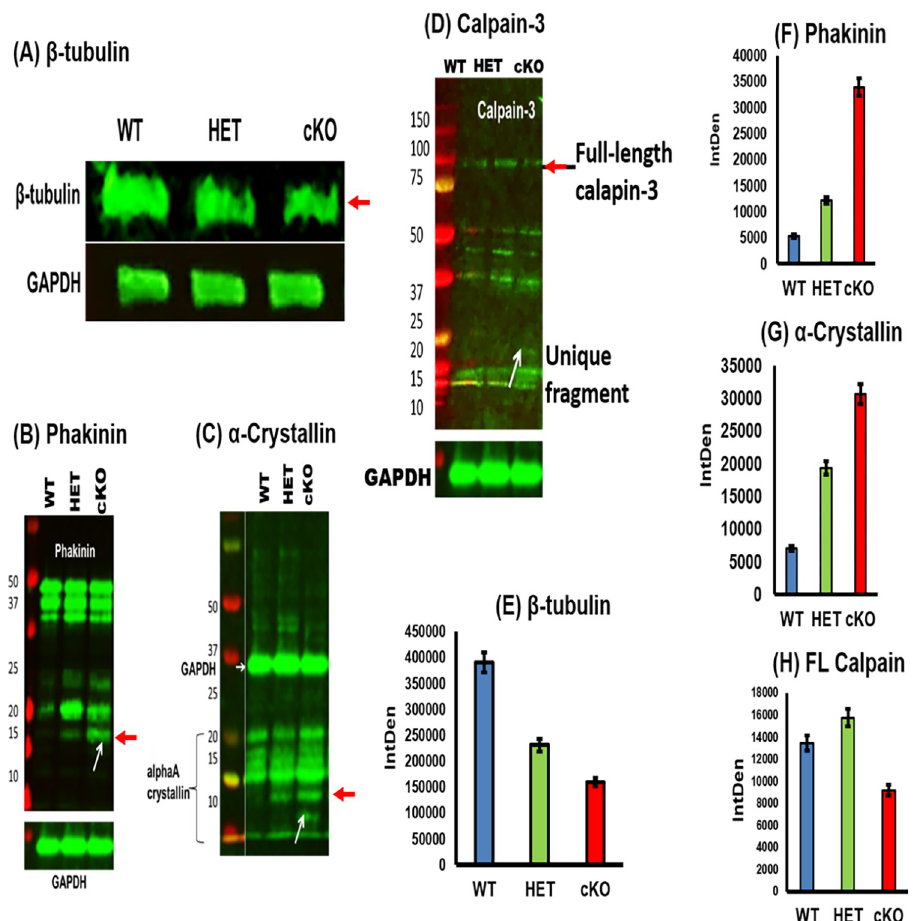
Fig 3. Increase in fragmentation of lens proteins in lenses of β A3cKO relative to wild type and β A3 heterozygous lenses as determined by western blot analyses. ( A) About 40% decrease was seen in the levels of β -tubulin in β A3cKO lenses relative to wild type and β A3 heterozygous lenses. GAPDH was used as loading control. (B) Increase in fragmentation of phakinin (lane 3, identified with an arrow) in β A3cKO lenses relative to wild type- and heterozygous lenses (lanes 1 and 2) (C) Increase in fragmentation of α A-crystallin in β A3cKO lens (lane 3, identified with an arrow) relative to wild type- and heterozygous lenses (lanes 1 and 2). (D) Increase in fragmentation of calpain-3 in β A3cKO lens (lane 3, identified with an arrow) relative to wild type- and heterozygous lenses (lanes 1 and 2). In (A), (B), (C) and (D), the β A3cKO lenses showed lower levels of full-length and additional fragmented protein bands of β -tubulin, phakinin, α -crystallin, and calpain, respectively relative to lenses from wild type- and heterozygous mice. In (C), an increase in fragmentation of α -A crystallin along with multimers of alpha A crystallin of different sizes were observed on SDS-PAGE analysis. The antibody raised against full-length α -A crystallin was used. β A3cKO lenses showed a decrease in the amount of different sized multimers and increase in the amount of α A-crystallin monomer and proteolyzed fragments, compared to the wild type lenses (Results not shown). The protein fragment bands in the far- right lanes shown by a red arrow of images (A), (B), (C) and (D) were quantified using Image J and are represented as bar graphs in Figs. (E), (F), (G) and (H),